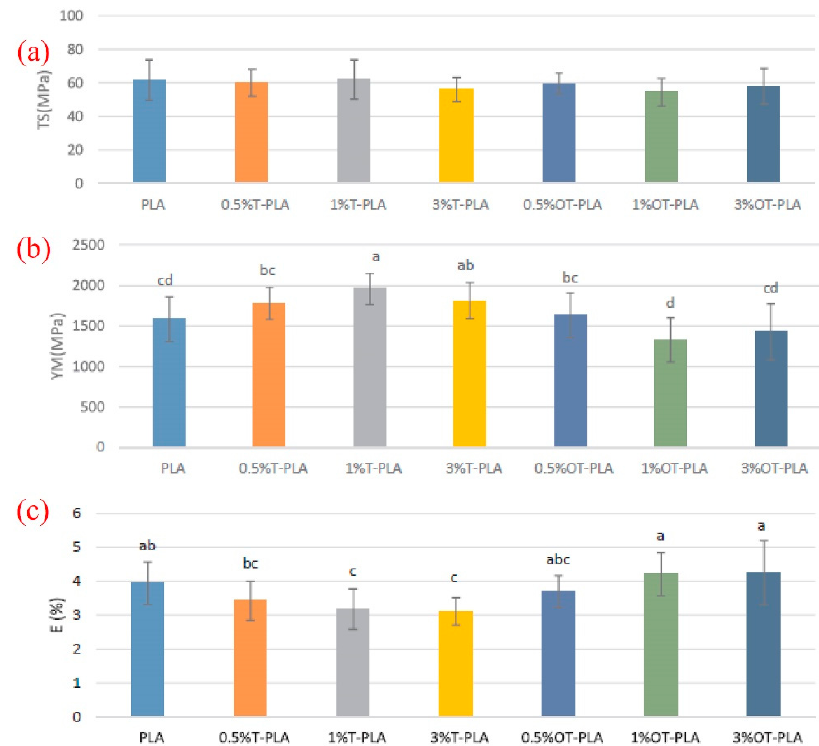
Figure 4. Mechanical results of PLA and PLA / TiO 2 composites containing 0, 0.5, 1, 3 wt.% of either modified TiO 2 or unmodified TiO 2 , where ( a ) TS, ( b ) YM and ( c ) EB (%) [28].